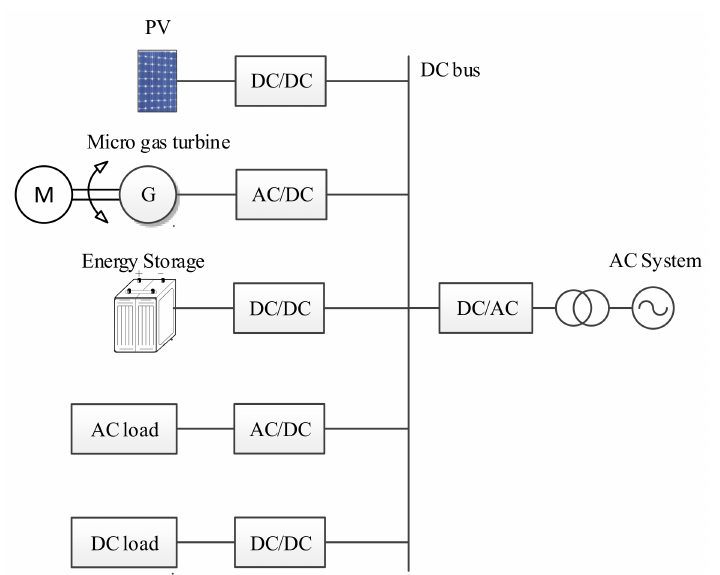
Figure 1. Topology diagram of grid-connected DC